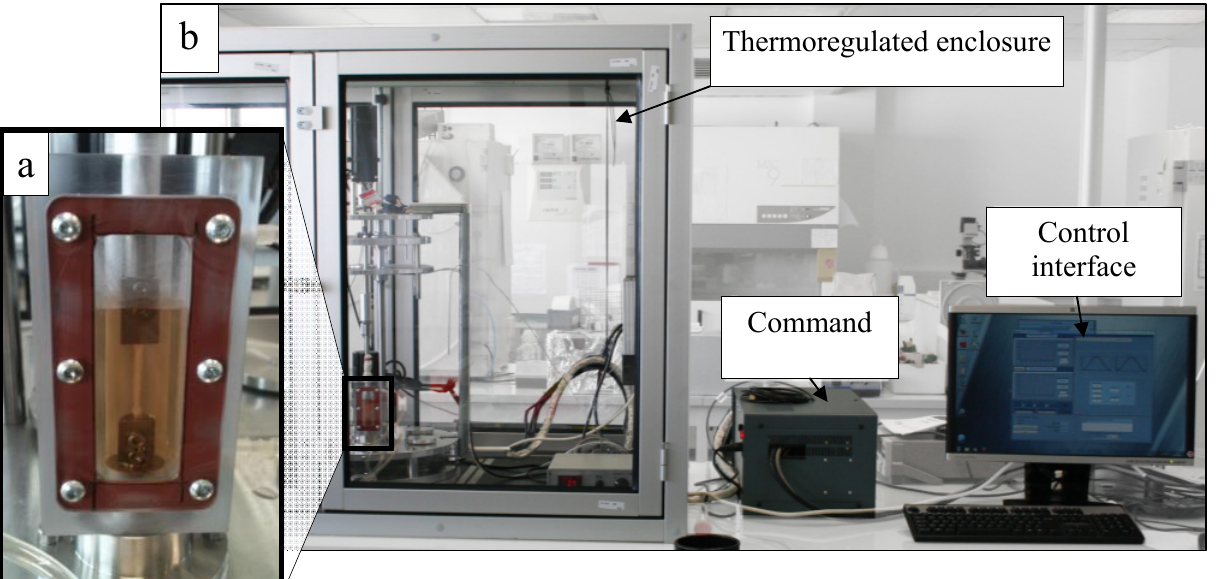
Figure 2. Multi-chamber tension-torsion bioreactor in its final configuration. ( a ) scaffold mounted in a bioreactor chamber ( b ) entire set-up including command and